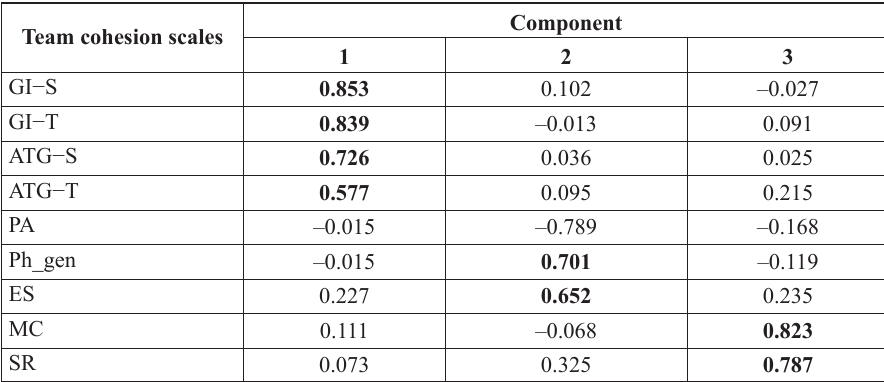
Table 4. Psychological and physical condition factor structure of Latvian youth basketball players Note. Extraction Method: Prin- cipal Component Analysis. Ro- tation Method: Varimax with Kaiser Normalization. a Rotati- on converged in 4 iterations. Team cohesion scales: GI-S, GI-T, ATG-S, ATG-T. Personal alertness (PA). Physical conditi- on (Ph_gen). Psychical stability scales: emotional stability (ES), motivation component (MC), self-regulation (SR)